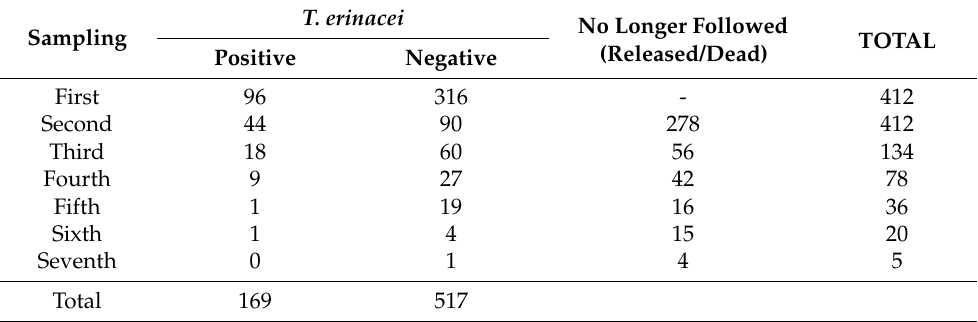
Table 1. Distribution of culture results over monthly sampling of European hedgehogs admitted to the rescue centre (Chuv-FS